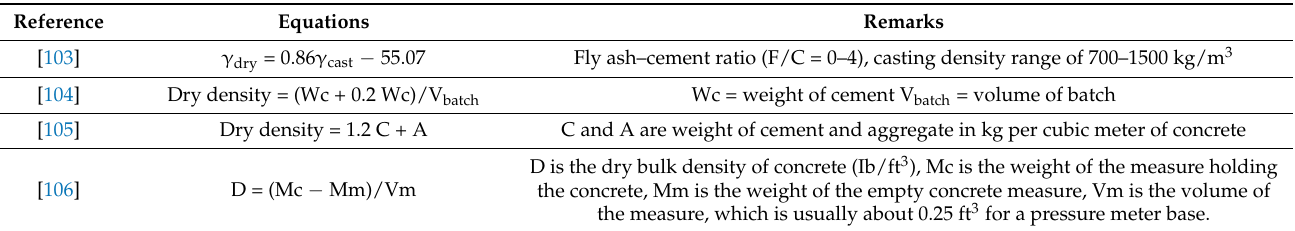
Table 9. Equations for density.